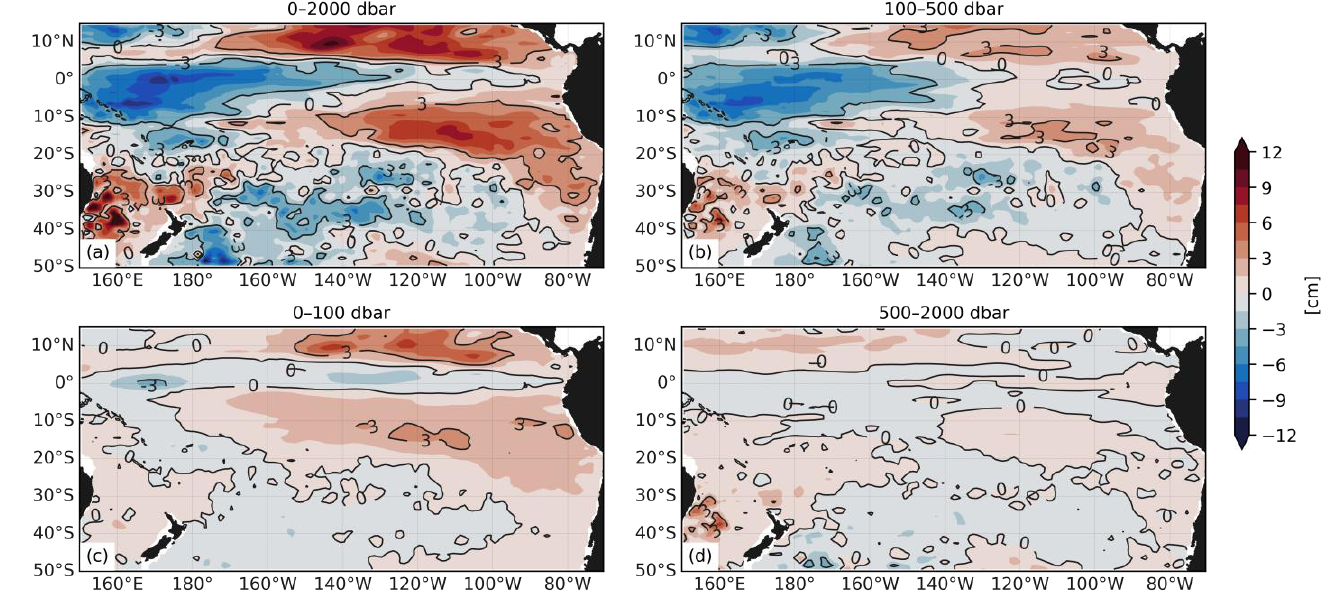
Figure 3. Differences in the Roemmich-Gilson Argo-based thermosteric sea level (TSL) for 2016 minus 2014 over ( a ) 0 – 2000 dbar, ( b ) 100 – 500 dbar, ( c ) 0 – 100 dbar and ( d ) 500 – 2000 dbar. Contour lines (see inline numbers for TSL intervals) are also shown.